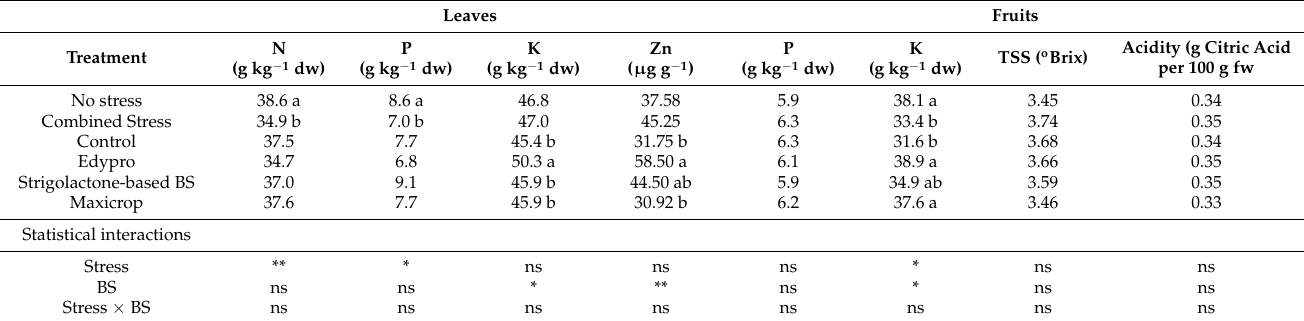
Table 5. Effects of combined restriction of water and nutrients and biostimulant (BS) application (Control: No biostimulant applied, Edypro: application of COUP É REGENERACI Ó N and PROCUAJE RADICULAR, strigolactone-based biostimulant, and Maxicrop) on N, P, K, Zn concentrations of tomato leaves and P, K, total soluble solids (TSS, o Brix) and acidity (g citric acid per 100 g of fresh fruit weight) on tomato fruits. Leaves